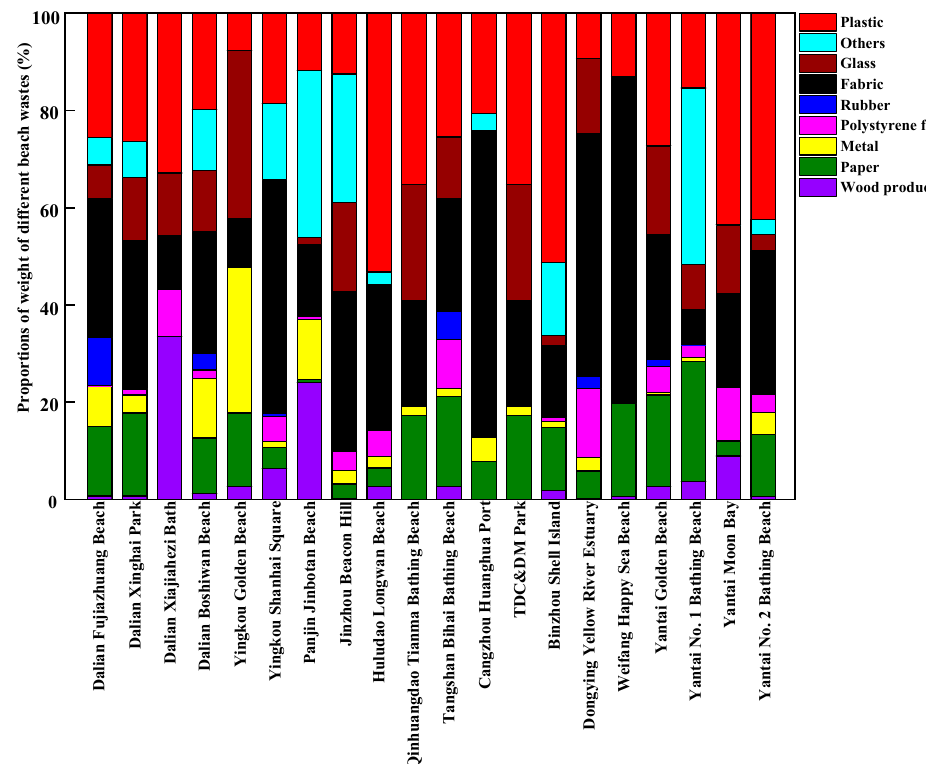
Figure 4. The proportions of different components of beach waste in coastal cities around the Bohai Sea of China in the tourist off-peak season, by weight.